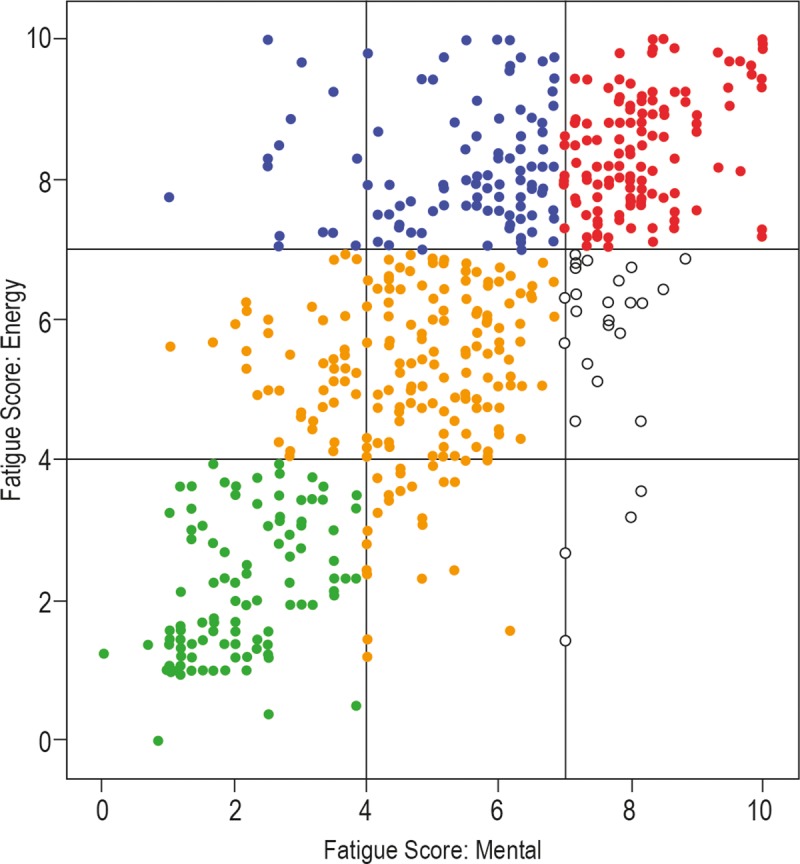
Distribution of all selected cases based on the individual scores in terms of energy fatigue and mental fatigue derived from the PFS.The scores are categorized as low level fatigue (0 < score < 4), medium level of fatigue (4 ≤ score < 7) and high level of fatigue (score ≥ 7). This distribution indicates the presence of five PFS groups: Low fatigue (green), mild fatigue (orange), mainly energy fatigue (blue), mainly mental fatigue (open circles), and high energy and mental fatigue (red).